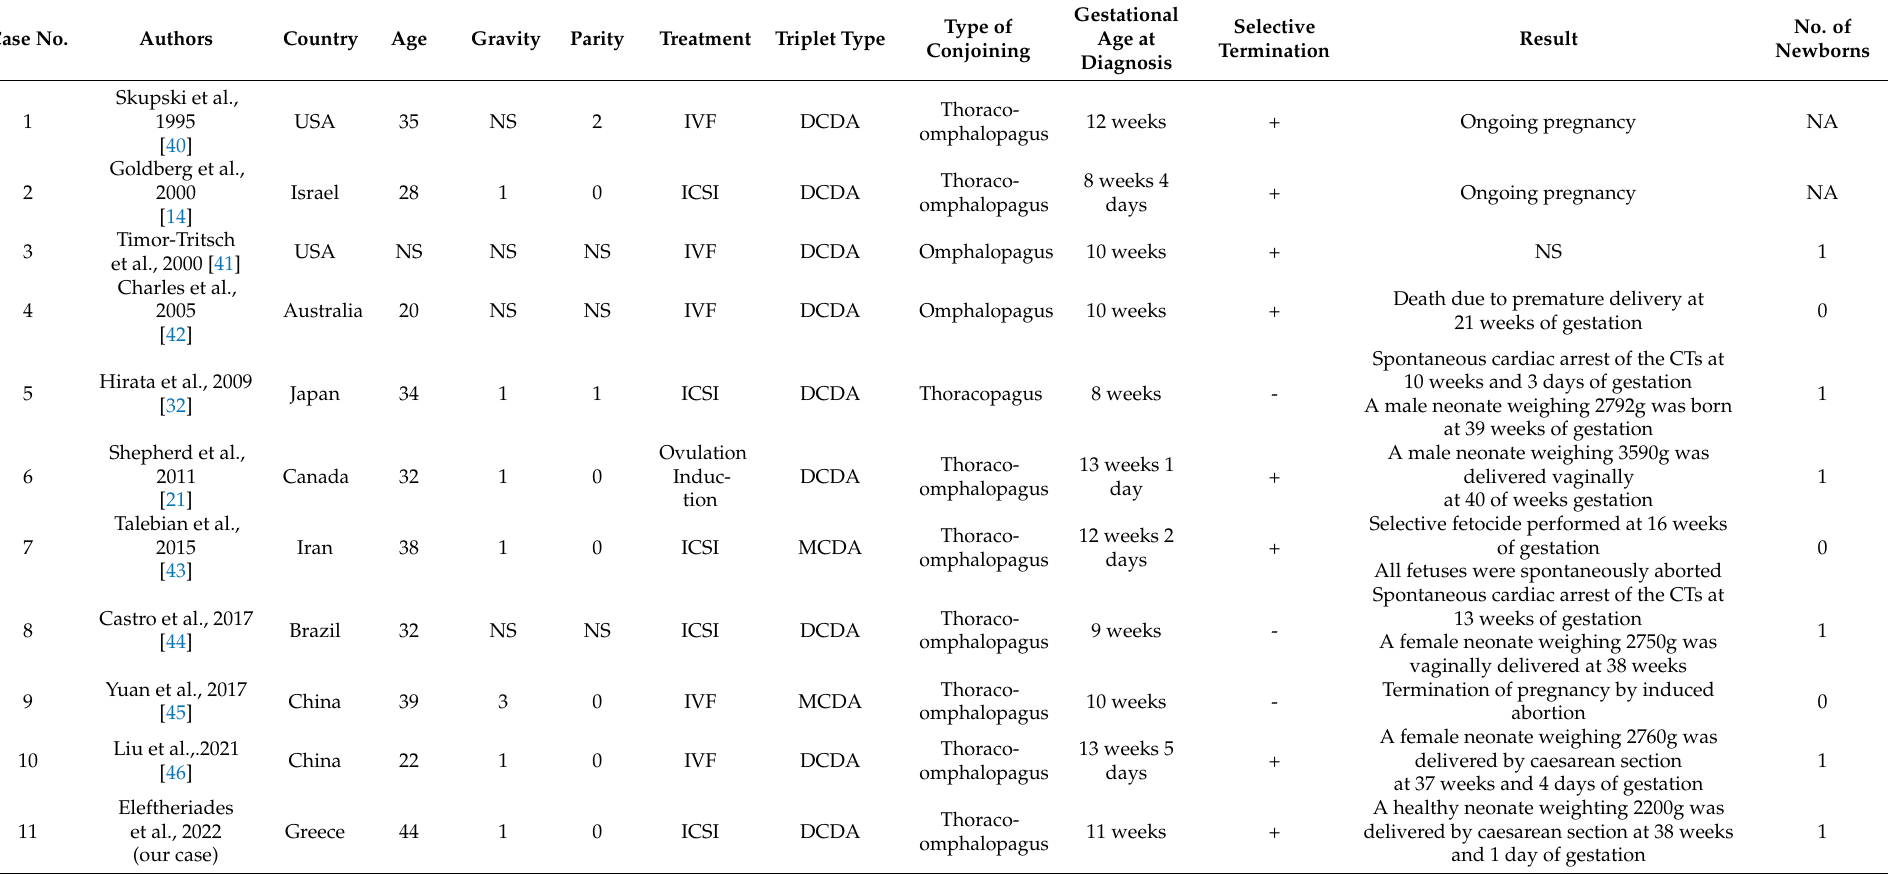
Table 1. Reported cases of triplet pregnancy with conjoined twins after assisted reproduction